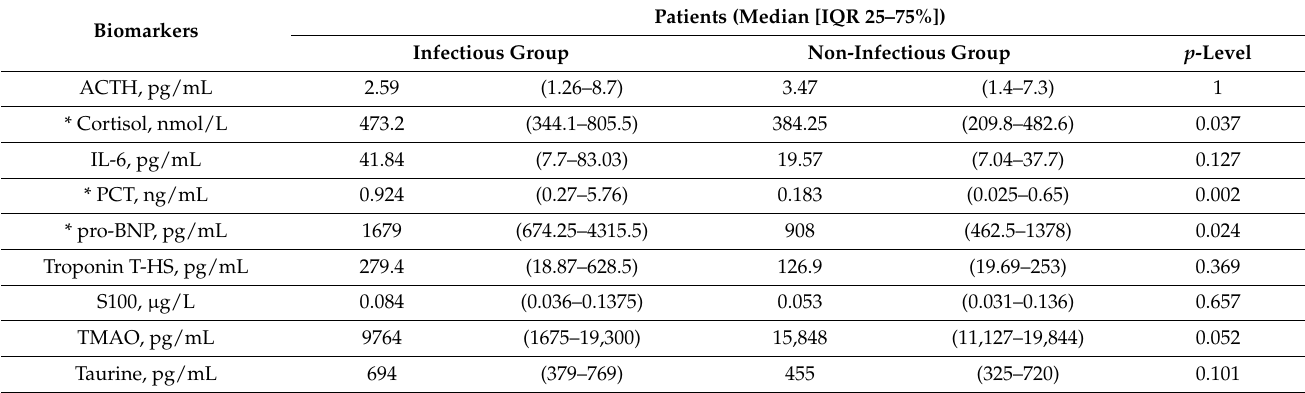
Table A1. Levels of biomarkers in groups of patients with infectious complications and without infectious complications. Data are presented as median and interquartile range